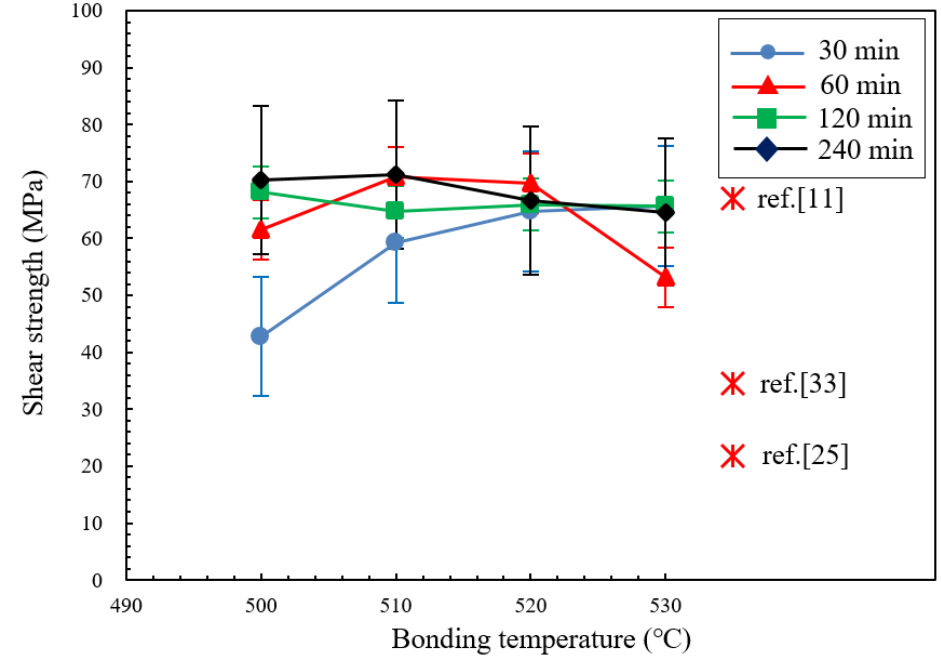
Figure 6. Bonding strengths of AA6061/AA6061 joints diffusion bonded at 500–530 °C for 30–240 min [11,25,33].